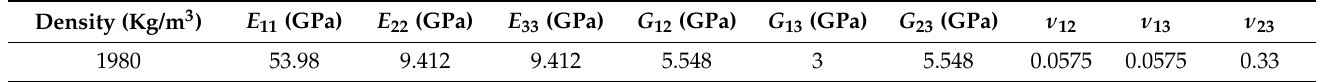
Table 4. Material data of S2-FM94 lamina used in the FE analysis.